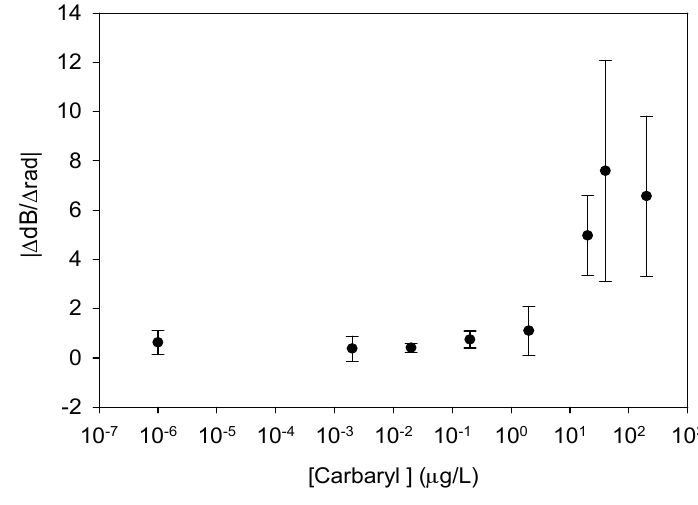
Figure 12 . Acoustic ratios for the different carbaryl standards for a MAb concentration of 2 μ g/mL and hapten-conjugate concentration of 10 μ